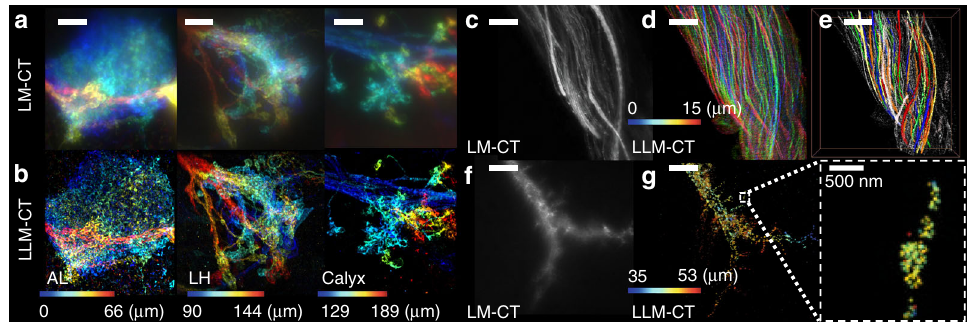
Fig. 4 Super-resolution images in D. melanogaster brain with LLM-CT. Comparison between LLM-CT and LM-CT. a , b Images of MZ19-Gal4 -labeled olfactory projection neurons in the antennal lobe (0 – 66 μ m), lateral horn (90 – 144 μ m), and calyx (129 – 189 μ m) taken with LM-CT ( a ) or LLM-CT ( b ). c – e Images of Fru-Gal4 -labeled fl y neck neurons taken with LM-CT ( c ) or LLM-CT ( d ). e More than 30 neurons were segmented manually across a 15- μ m imaging depth. f , g The dendritic arbors of a giant- fi bre neuron expressing UAS-Dscam::GFP imaged with LM-CT ( f ) or LLM-CT ( g ). 3D images were color- depth coded in each fi gure. Scale bars = 10 µ m, unless otherwise indicated